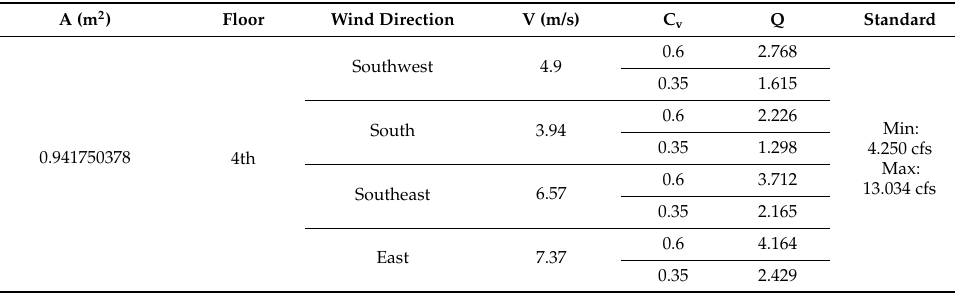
Table 7. Existing window: Indonesian National Standard Calculations.